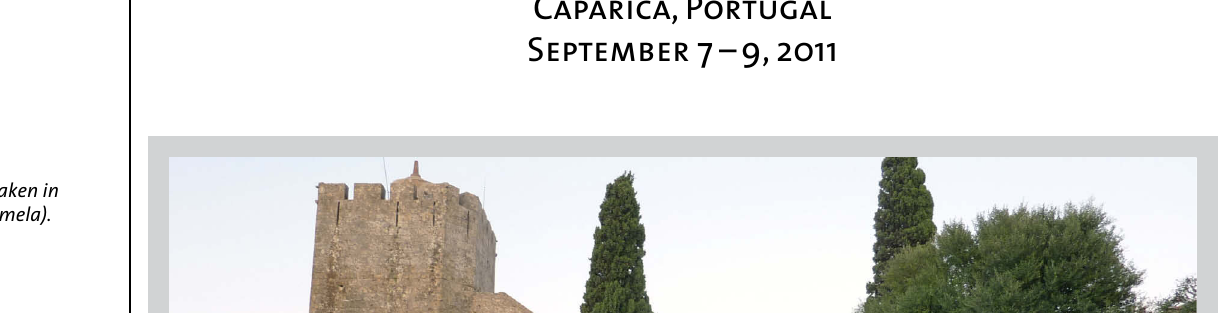
Figure 1: Group photo (taken in Pousada de